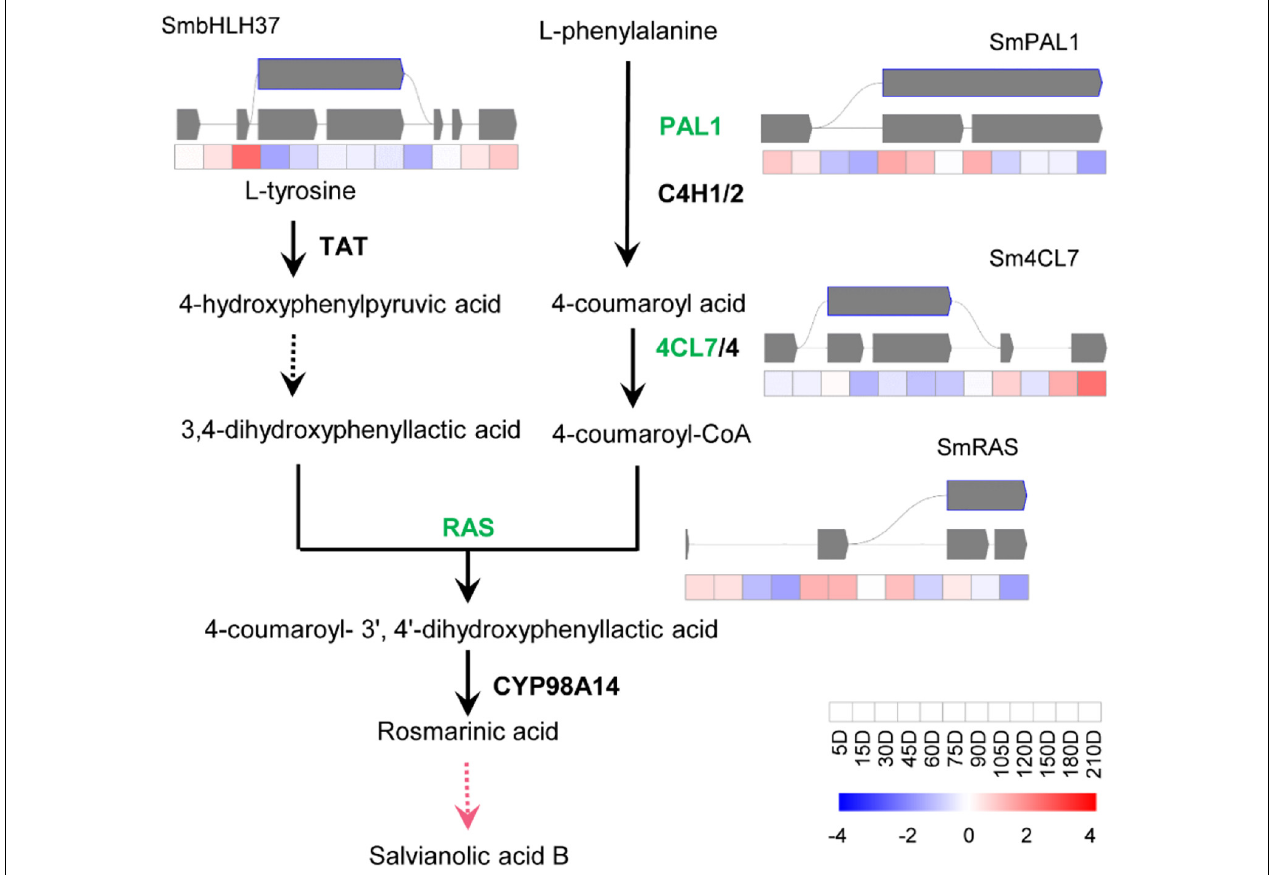
FIGURE 4 | Transcript levels and alternative splicing isoforms of RA biosynthetic genes and TF. The yellow boxes, purple boxes, blue frames, and green frames indicate Alt.3 (cid:48) , Alt.5 (cid:48) , IR, and ES splicing patterns, respectively. The black lines indicate the known enzymes, the pink line indicates the unknown enzyme. The gay lines indicate introns, gray squares represent